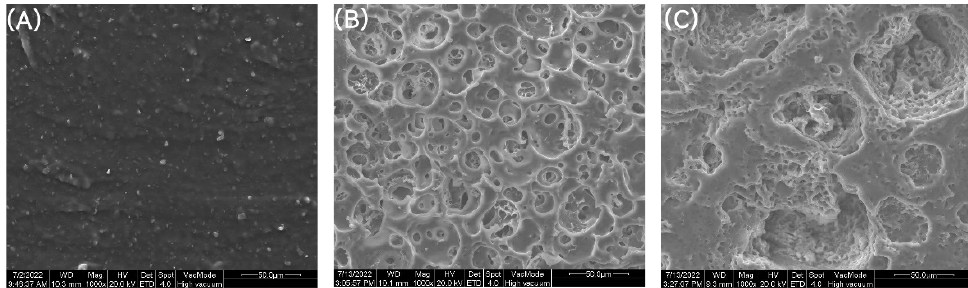
Figure 6. ESEM of gel 1 ( A ); gel 2 ( B ); gel 3 ( C